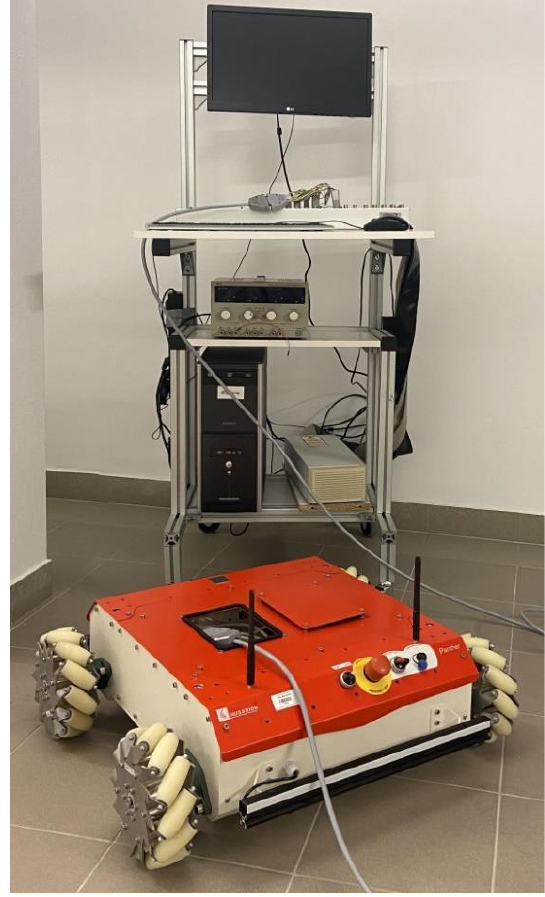
Figure 7. The laboratory stand.